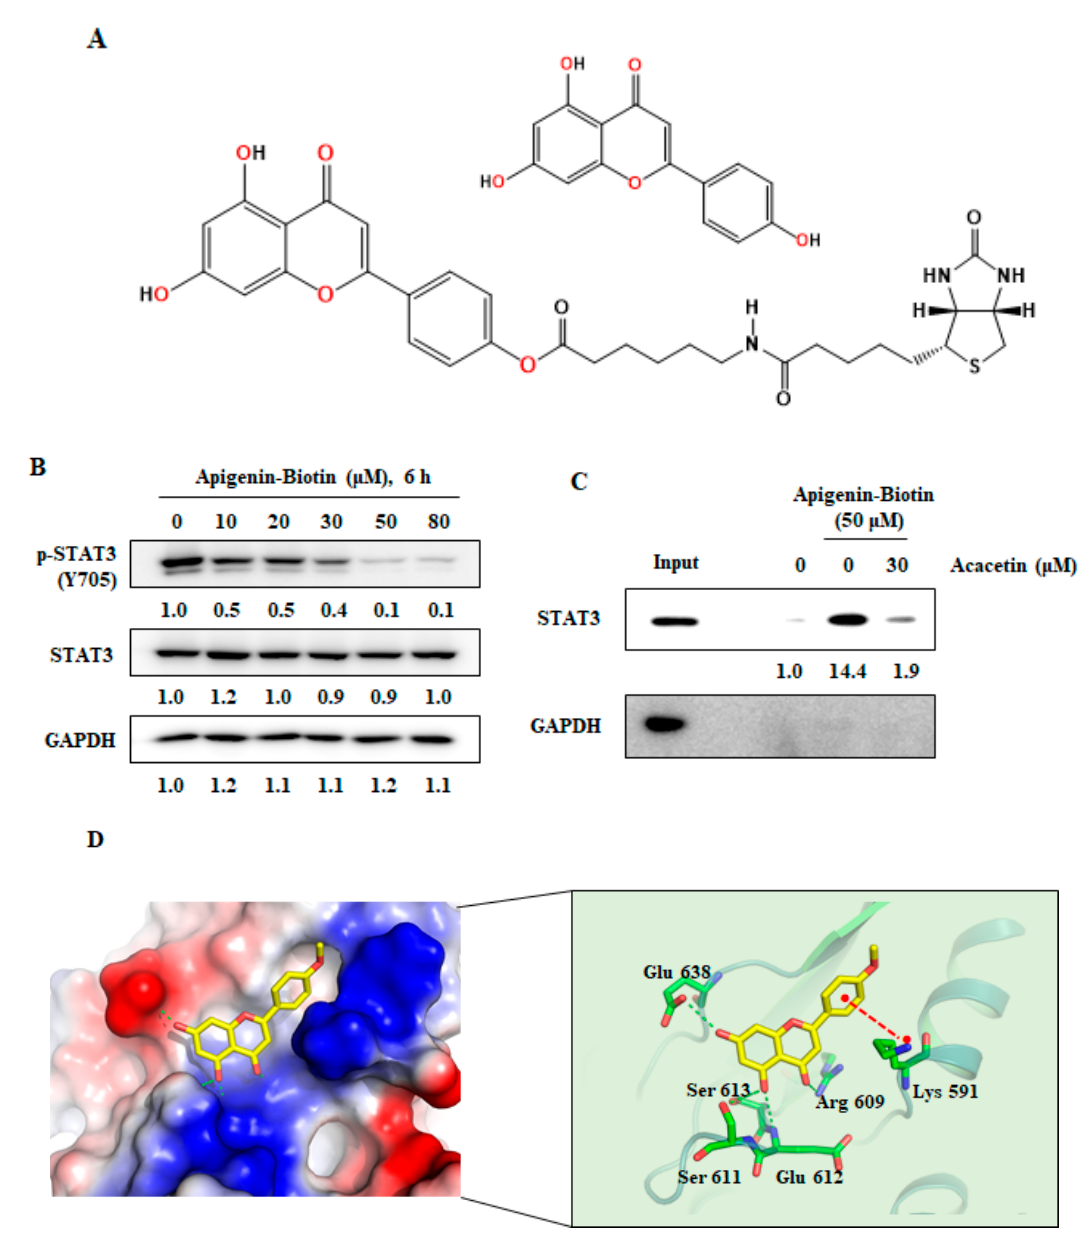
Figure 5. Acacetin binds to STAT3 and inhibits STAT3 activity. ( A ) Structure of apigenin and biotinyl–apigenin. ( B ) Biotinyl–apigenin induced the dephosphorylation of STAT3 in DU145 cells. DU145 cells were treated with the indicated concentration of biotinyl–apigenin for 6 h. Whole-cell lysates were analyzed using Western blotting. ( C ) DU145 lysates were incubated with DMSO or biotinyl–apigenin and then competed with acacetin at the indicated concentration. Binding protein was captured by NeutrAvidin agarose resin and eluted by boiling in SDS-PAGE sample buffer. The eluted protein was analyzed using Western blotting. ( D ) Structural model for acacetin in complex with STAT3. Acacetin is colored yellow, and hydrogen bonds between acacetin and STAT3 are shown as green dotted lines, and a cation– π interaction is shown as a red dotted line.